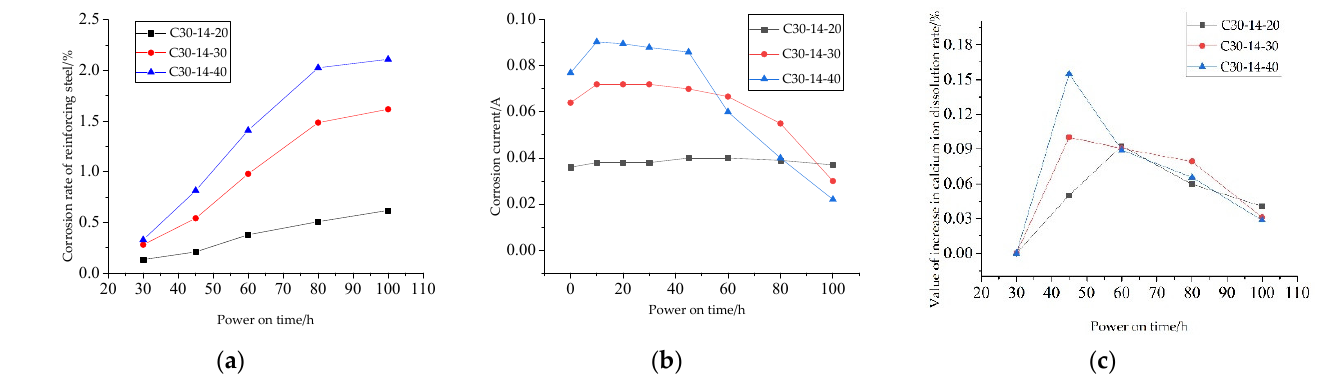
Figure 5. Change curve of corrosion rate of reinforcement. ( a ) Corrosion rate of reinforcement; ( b ) Corrosion current; ( c ) Change value of calcium ion dissolution rate.